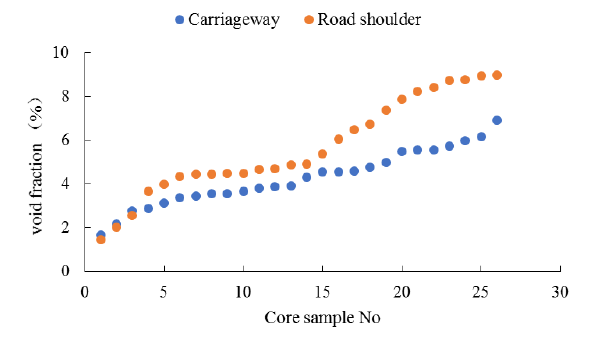
Fig. 4 Core CT scan void fraction.